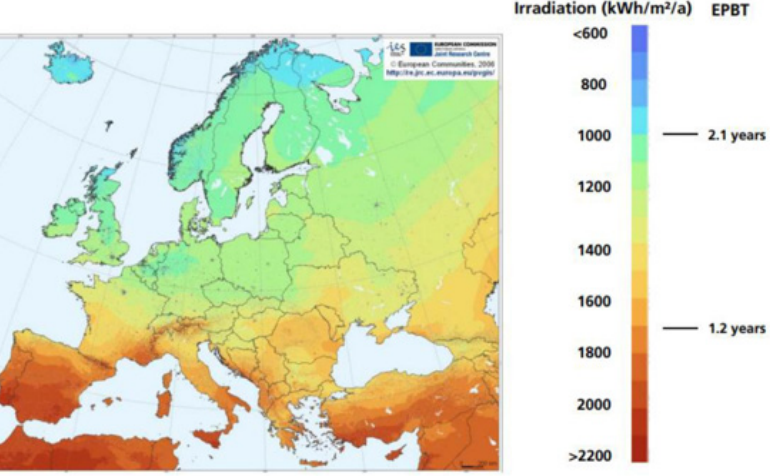
Figure 2. Irradiation and EPBT (energy payback time) in European countries according to the JRC European Commission [20].